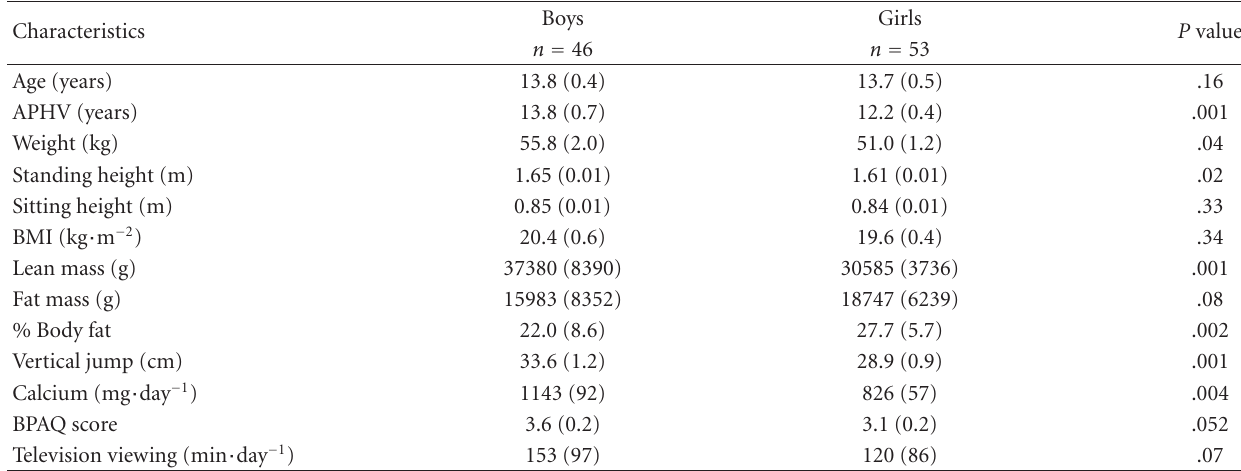
Table 1: Subject characteristics for adolescent boys and girls ( n = 99). Mean